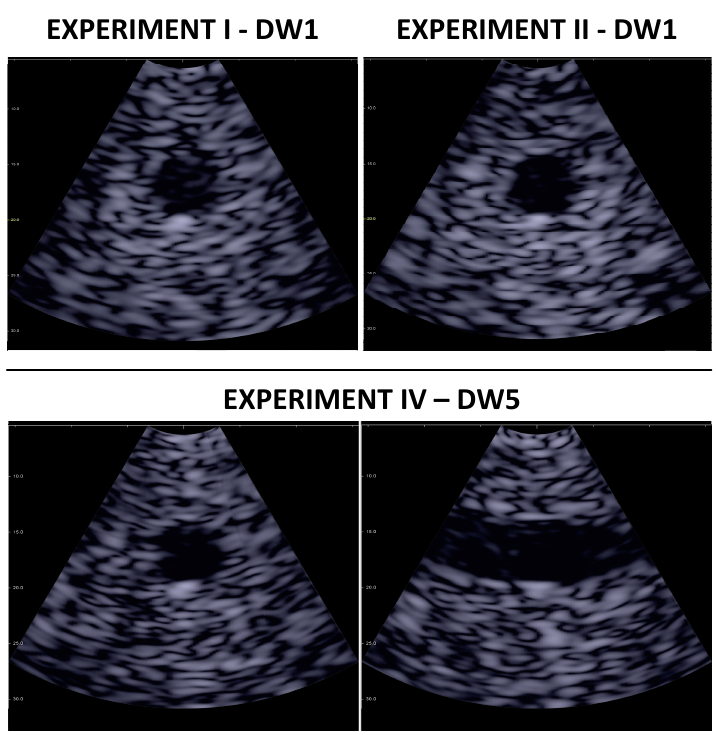
Figure 4. Sample screenshots of the real-time user interface of ULA-OP 256 during phantom investigation. Top panels: sample images obtained with diverging wave transmission (DW1) from 128 (Experiment I) and 256 (Experiment II) elements of the 2-D Vermon probe. Bottom panels: bi-plane (Experiment IV) transverse ( left ) and longitudinal ( right ) “compounded” views, simultaneously obtained through the transmission of five diverging waves (DW5).